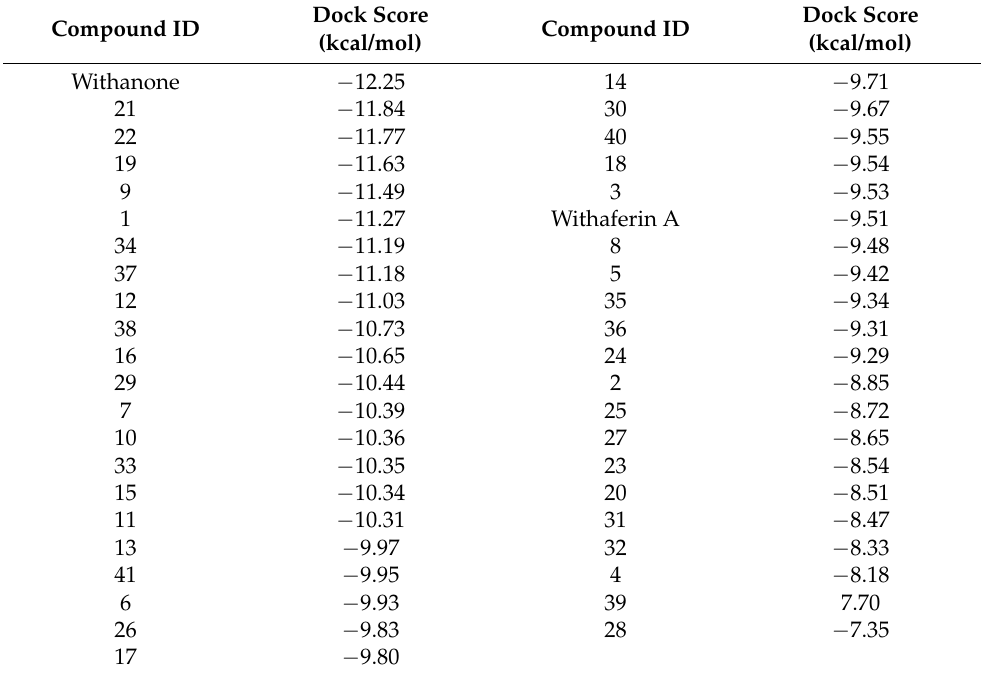
Table 3. The docking score of studied compounds on protein Mortalin (PDB